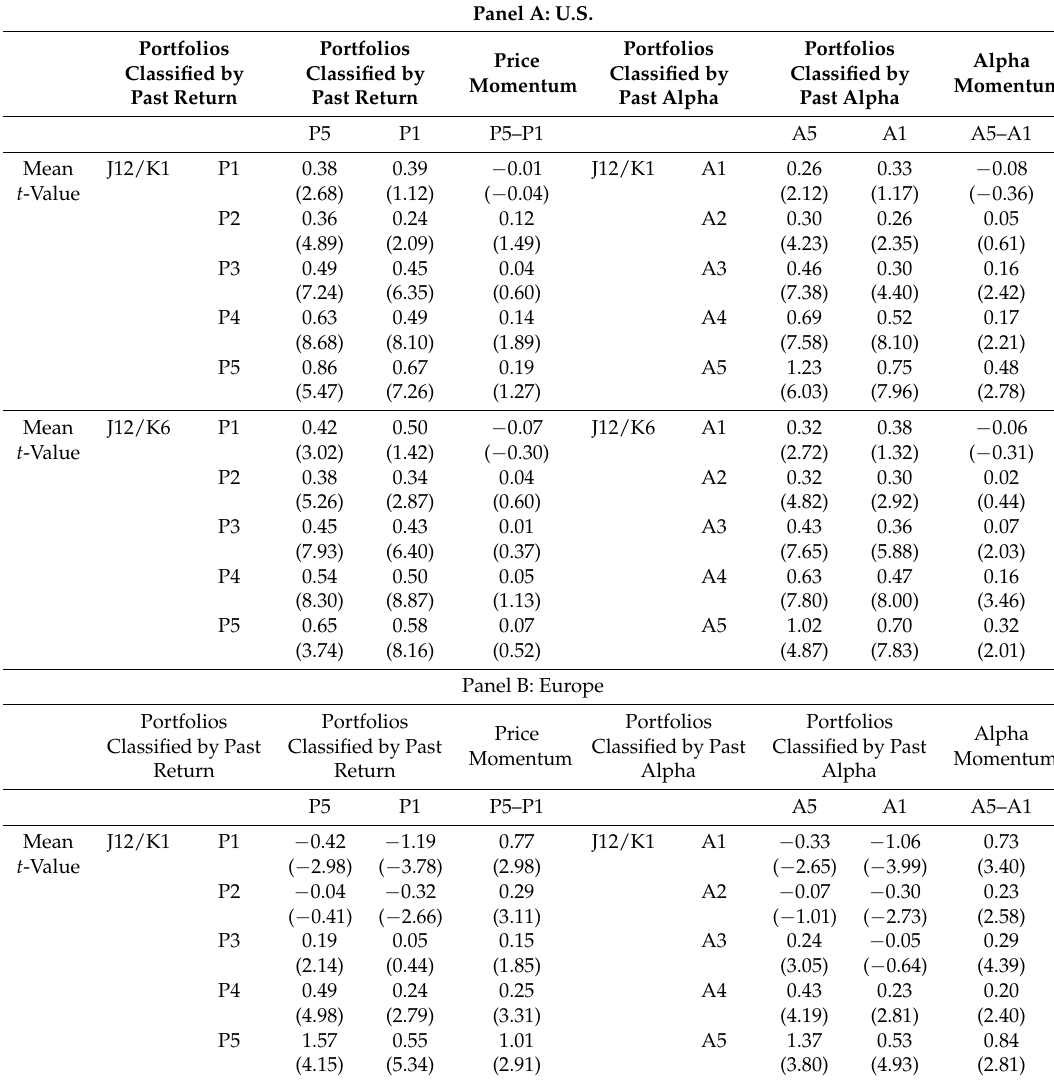
Table 4. Monthly risk-adjusted returns of double-sorting stocks on the same criterion. Panel A: